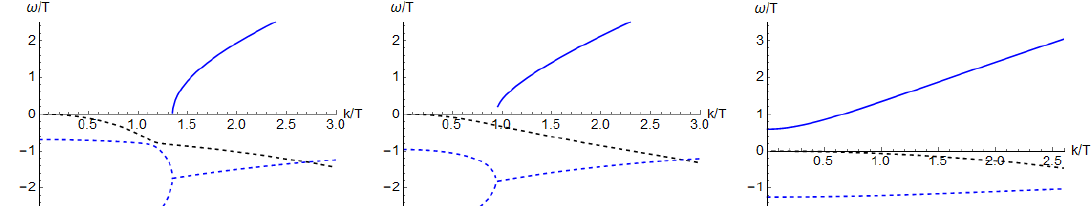
Figure 3 . Dispersion relations of collective modes at (cid:12)xed momentum relaxation rate (cid:0), encoded in the dimensionless parameter (cid:11)=T = 3 (more precisely (cid:0) = (cid:11) 2 = 2 (cid:25)T ). Solid lines are the real parts, dashed lines imaginary. Similarly colored dashed and solid lines correspond to the same mode. Left panel: for small chemical potential, (cid:22)=T = 0 : 1. Central panel: for intermediate chemical potential, (cid:22)=T = 1. Right panel: for large chemical potential, (cid:22)=T =